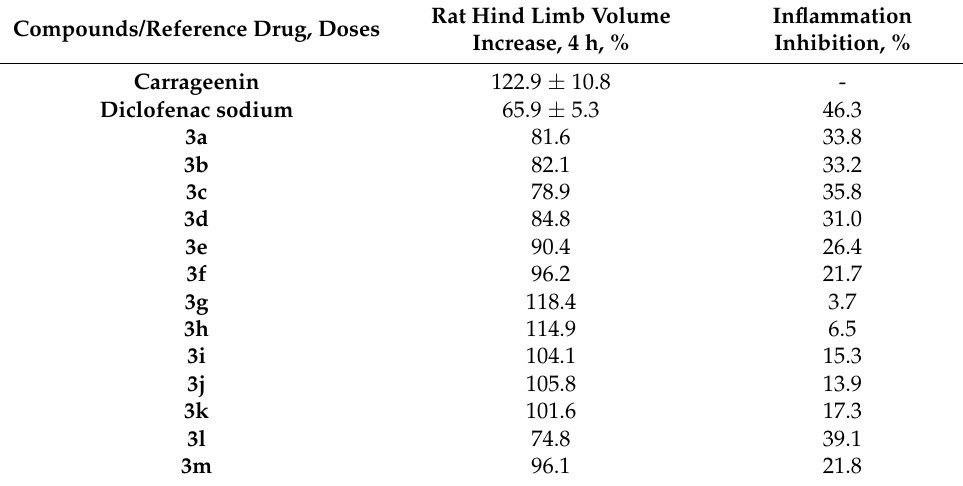
Table 3. In vivo anti-inflammatory activity of compounds 3a – m on carrageenin-induced paw edema in white rats (intraperitoneally use; doses: carrageenin 1%, 0.1 mL; Diclofenac sodium—8 mg/kg, tested compounds—50 mg/kg; M ± m; n = 6 in each